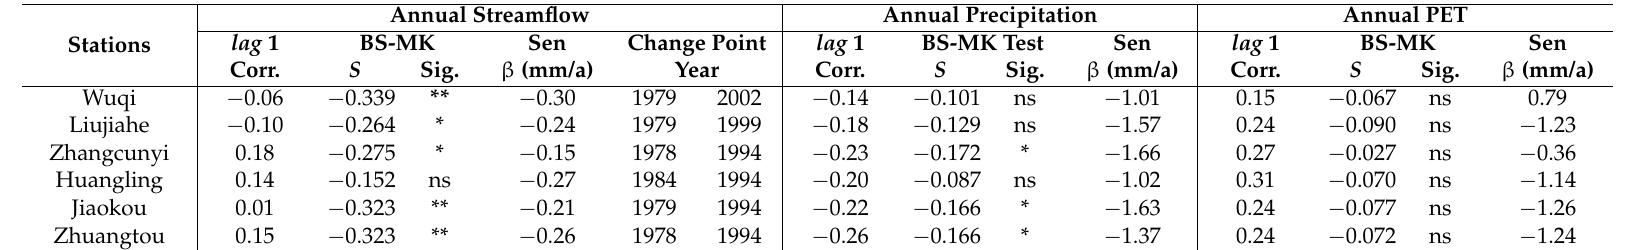
Table 3. Summary of annual streamflow, precipitation, and PET trends in each sub-catchment from the 1950s to 2011.